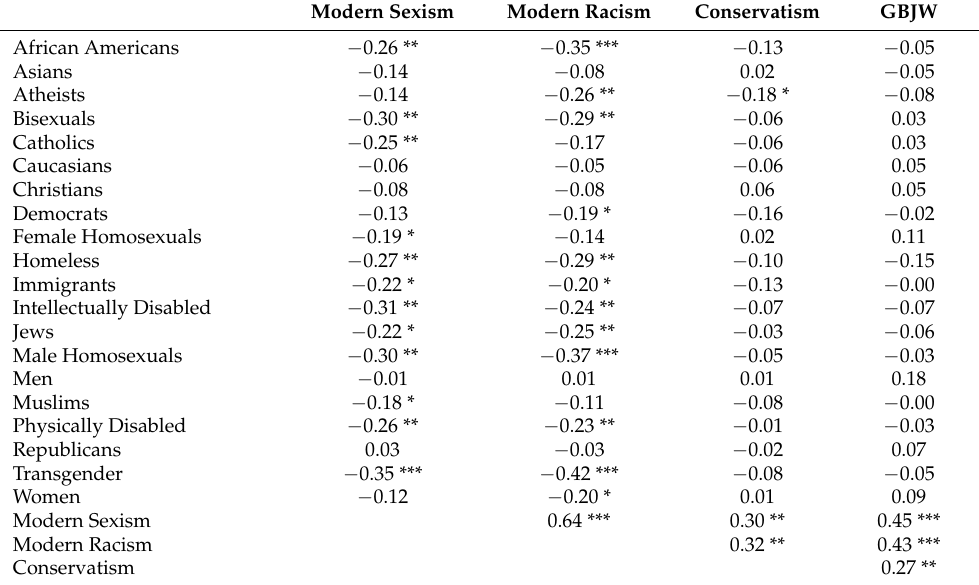
Table 3. Correlations among Ratings of Intelligence, Modern Sexism, Modern Racism, Conservatism, and